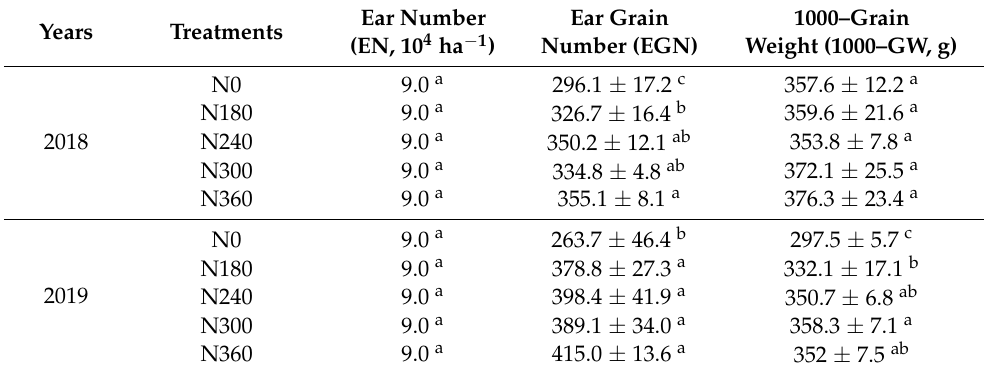
Table 2. Effect of the nitrogen application rate on the summer maize grain yield composition.